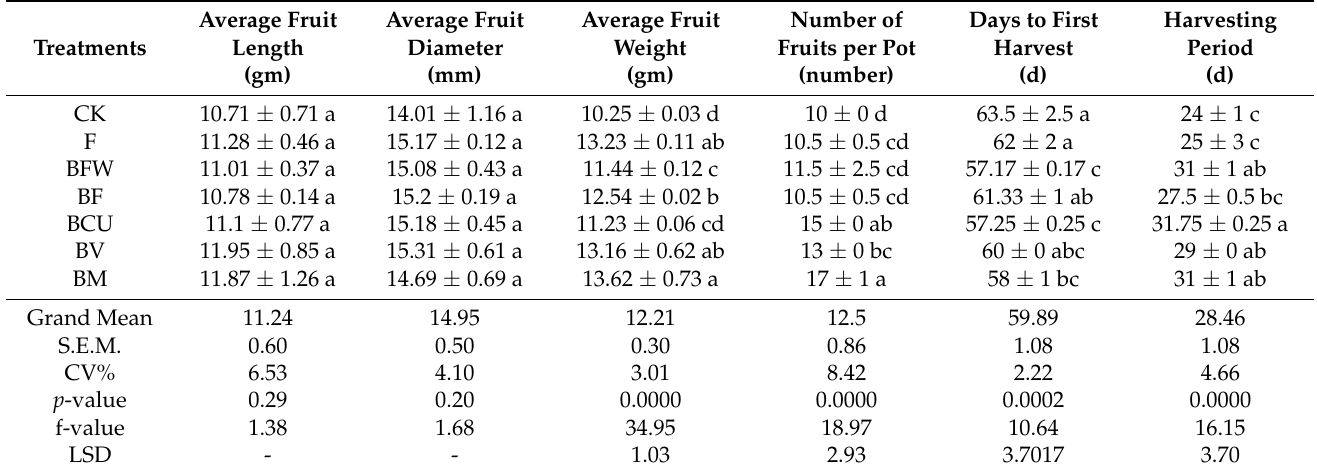
Table 5. Effect of biochar-blended organic and inorganic fertilizers on the yield parameters of okra. Values are means ± standard deviation, followed by the different letters in the column denoting significant differences at the 0.05 level using Tukey’s HSD